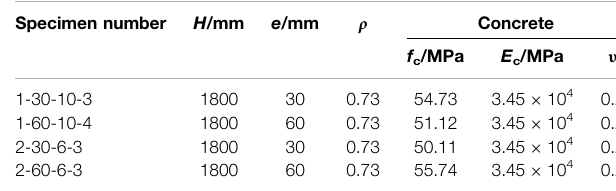
TABLE 3 | Speci fi c parameters of four